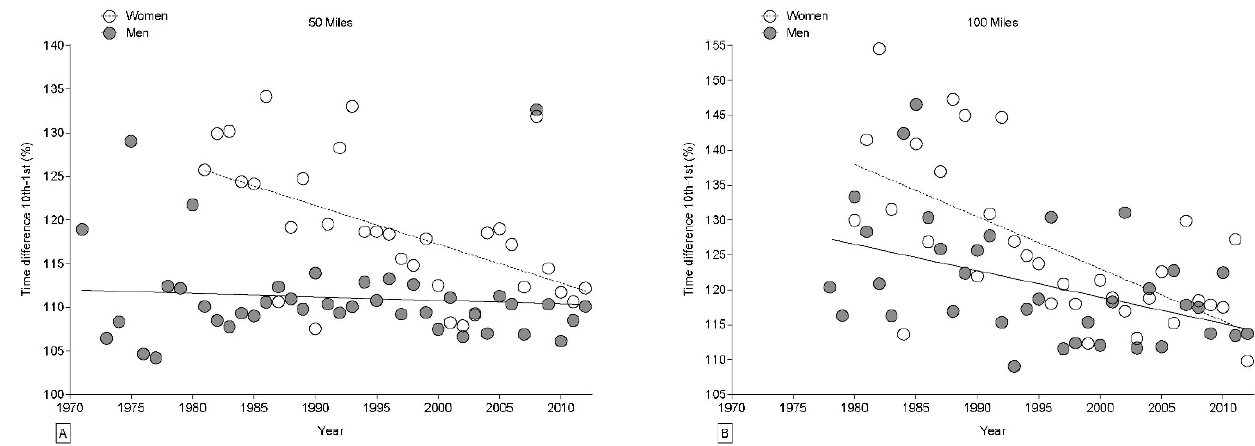
Figure 2 - The running speed ratio between the winner and the 10 th place expressed as the percentage of the winner’s time for 50 miles (Panel A) and 100 miles